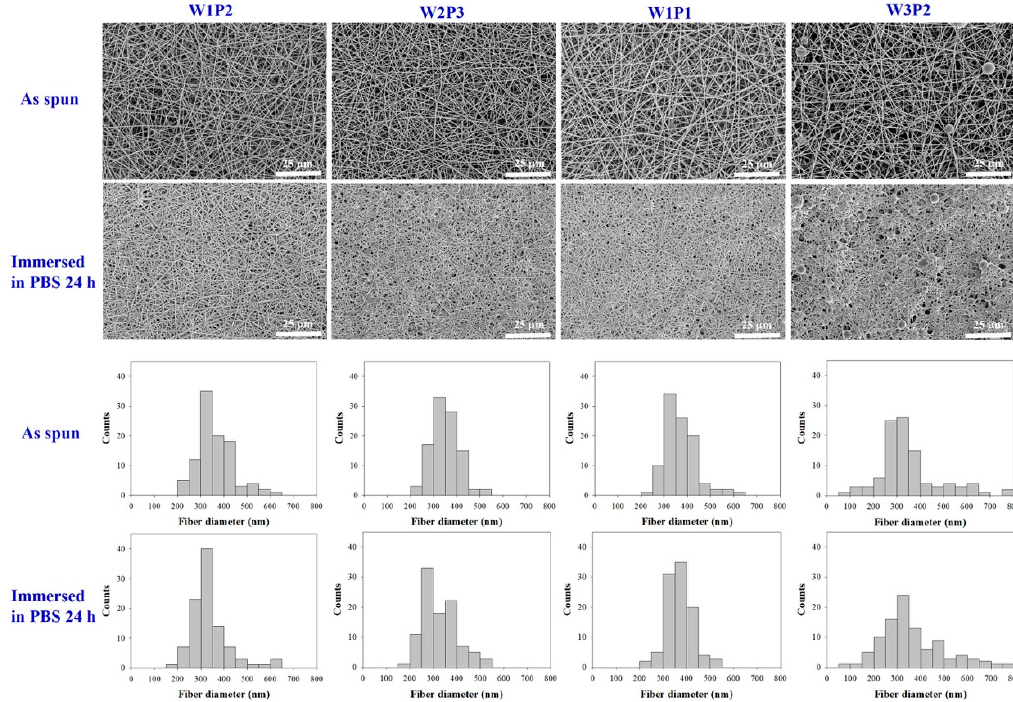
Figure 1. Scanning electron microscopy (SEM) images of electrospun fibers with different compositions of water-borne polyurethane (WPU) and poly-ethylene-oxide (PEO) before and after a phosphate-buffered saline (PBS) treatment: The respective distributions of fiber diameter are plotted as histograms. The SEM images of W3P2 show the bead formation and loss of shape of the fibers after a PBS treatment. W1P1 contains more WPU than W2P3 and W1P2, and its fibers had a preserved shape after the PBS treatment, indicating the stability of the fibers.